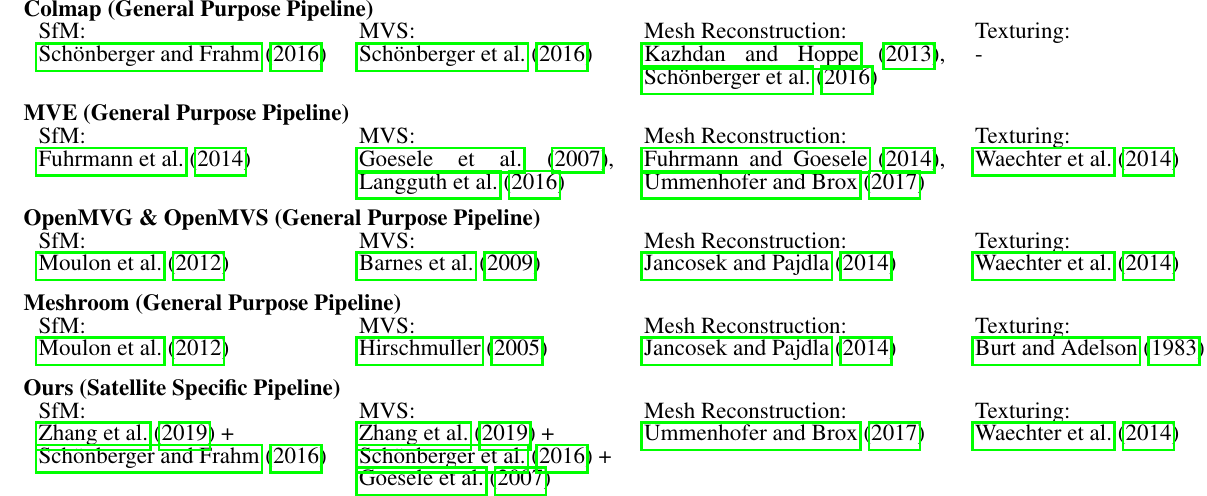
Table 1. Comparison of our pipeline proposed for satellite reconstruction with state-of-the-art (general purpose) reconstruction pipelines including Colmap (Sch¨onberger and Frahm, 2016), MVE (Fuhrmann et al., 2014), OpenMVG & OpenMVS (Moulon et al., 2013; Cernea, 2021) and Meshroom (AliceVision, 2018).